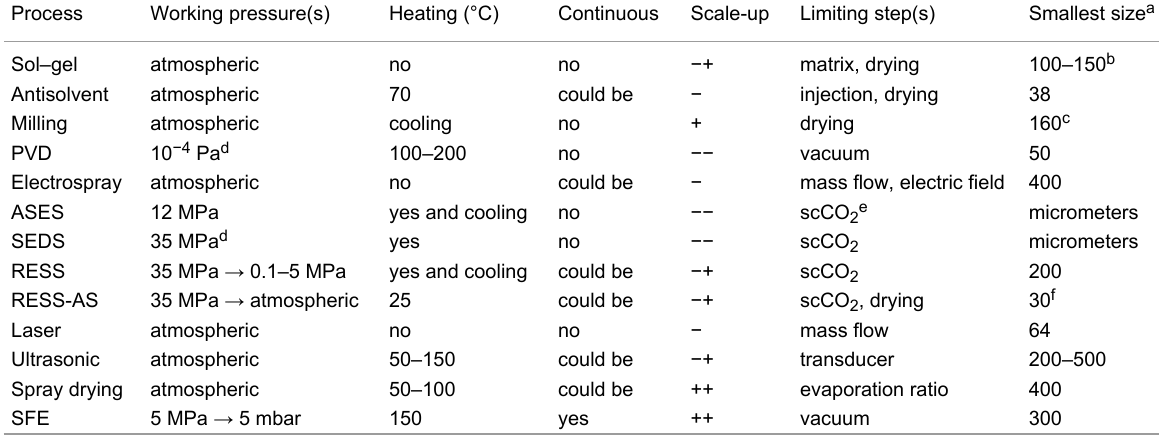
Table 6: Comparison and summary of the major techniques for the nanocrystallization of energetic materials with an industrial point of view.